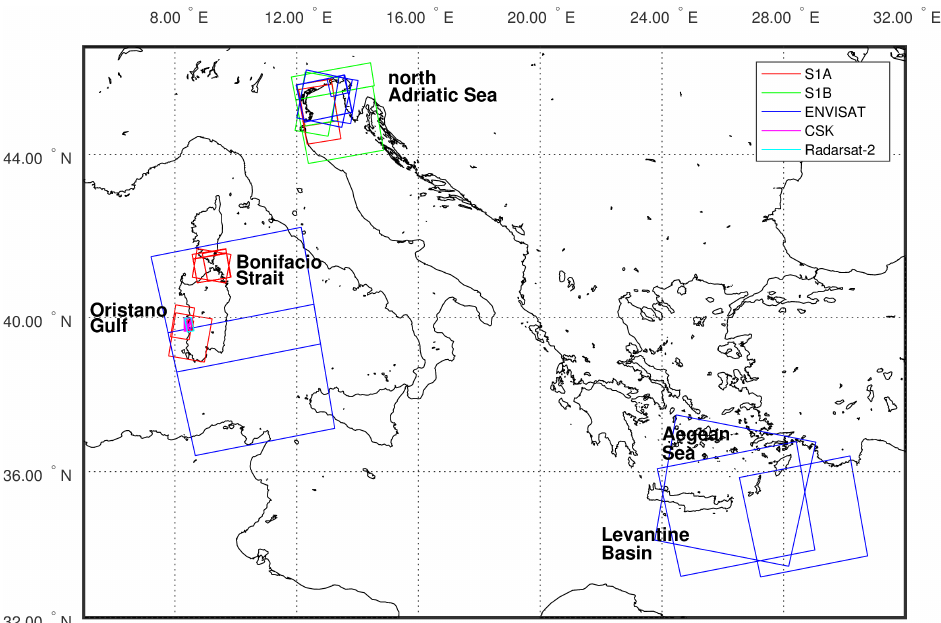
Figure 1. The frames of the Synthetic Aperture Radar images used in this work in the Mediterranean Sea. S1A/B: Sentinel-1 A/B; Envisat: ASAR WS; CSK: COSMO-SkyMed; Radarsat-2: Scansar Narrow.